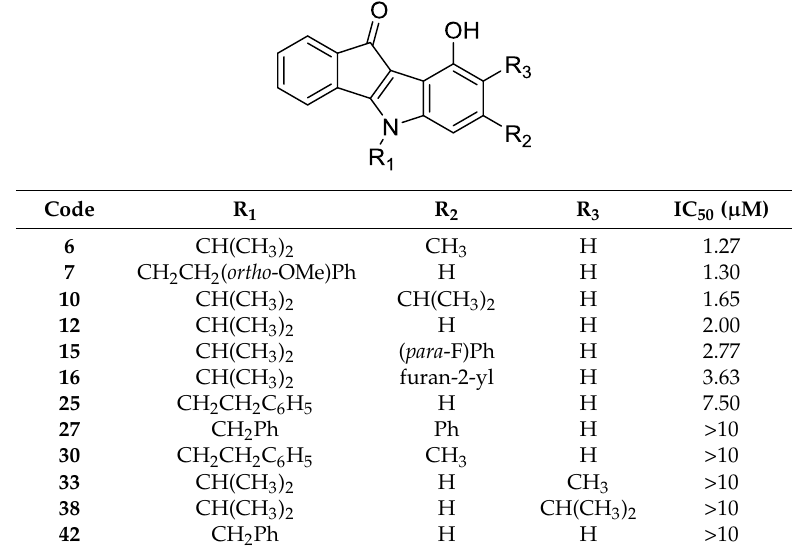
Table 2. Structures of the phenolic indeno[1,2- b ]indoles and their IC 50 values towards CK2, which were used for the training and test sets, data from Hundsdorfer et al. [10], and Gozzi et al. [12].